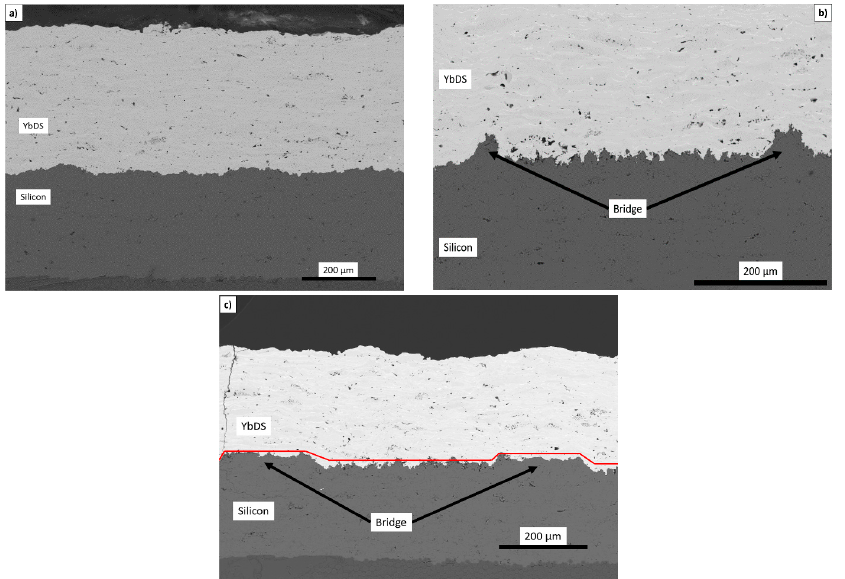
Figure 5. Line profiles of an unstructured ST1 ( a ) and a lattice-structured ST3 ( b ) silicon bond coat with 200 µ m wide bridges and 400 µ m basin structures, recorded by confocal microscopy.